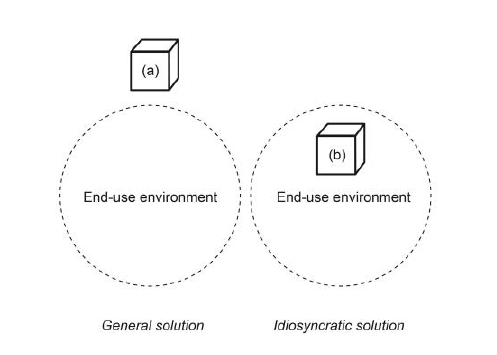
Figure 1. Relation between design solutions (general and specific) and end-use